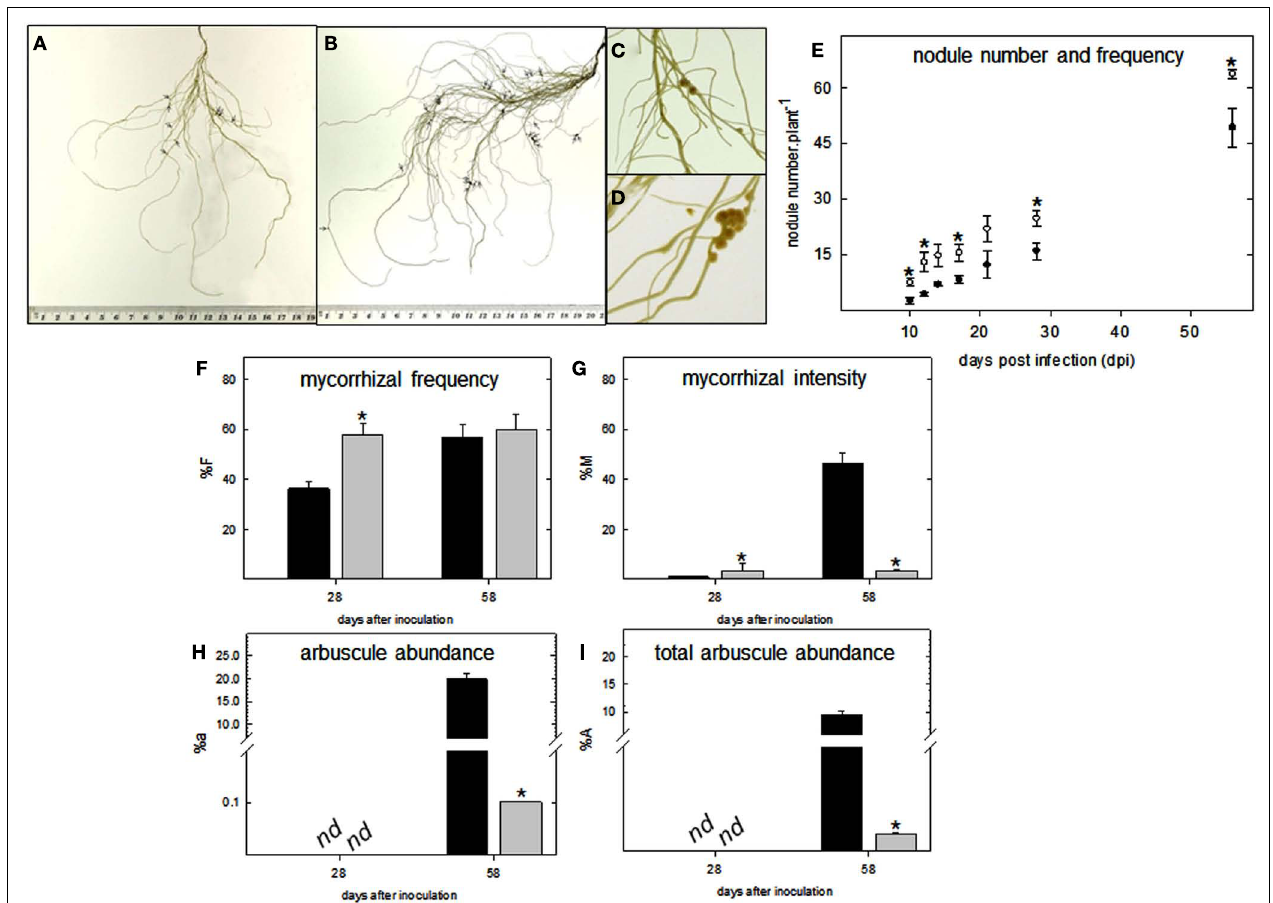
intensity of mycorrhizal colonization in the root system (% M ), (H) arbuscule abundance in mycorrhizal parts of root fragments (% a ) and (I) arbuscule abundance in the root system (% A ) of tomato root controls (black bar) and pre-treated with lumichrome (gray bar) at 28 and 58days after inoculation with Glomus spp.The values are the average ± SE for four independent replicates [of 15 root fragments each, (F–I) ] and an asterisk indicates a value that was determined by Student’s t -test ( P < 0.05) to be significantly different from the control. nd, not